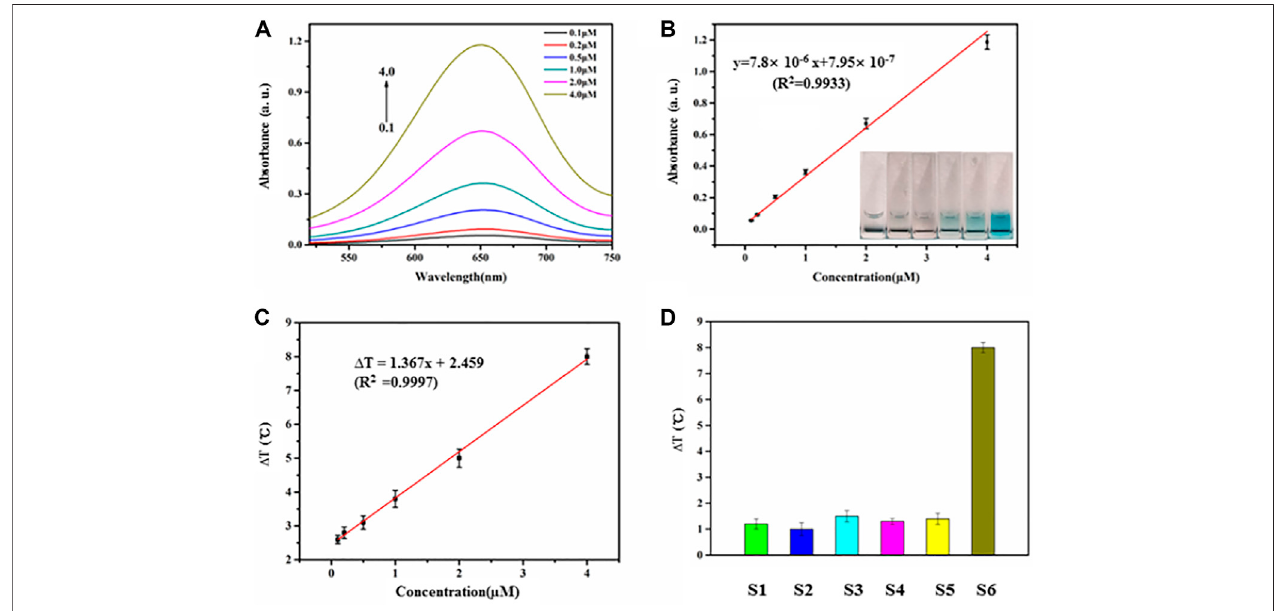
FIGURE 4 | (A) Absorbance intensities at 650 nm were obtained upon addition of miR21 with different concentrations (0.1, 0.2, 0.5, 1.0,2.0, 4.0 µM). (B) The relationshipofabsorbanceintensitiesandmiRNAconcentration.TherangeofmiR21concentrationisfrom0to4.0 µM. (C) Therelationshipoftemperatureevolutionand miRNA concentration from 0.5 to 4.0 µM. (D) Investigation of the selectivity of the miRNA-responsive HRP encapsulated DNA hydrogels/TMB- H 2 O 2 (S1, miR18; S2, miR205; S3, miR141; S4, miR25; S5, miR183; S6, miR21).